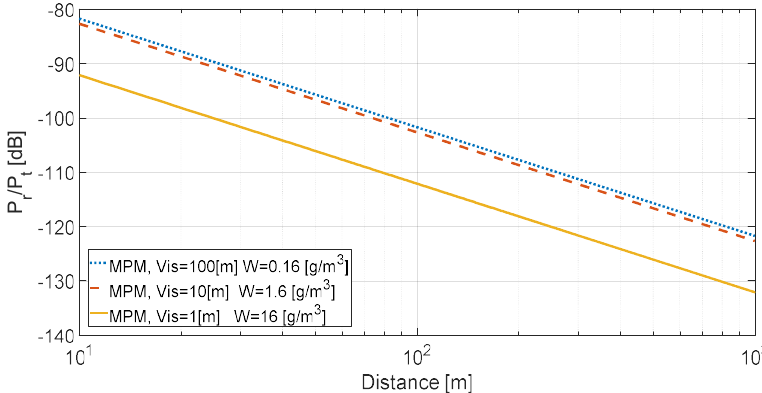
Figure 3. Graphs of the 28 GHz link budget power ratio Pr/Pt as a function of distance d.